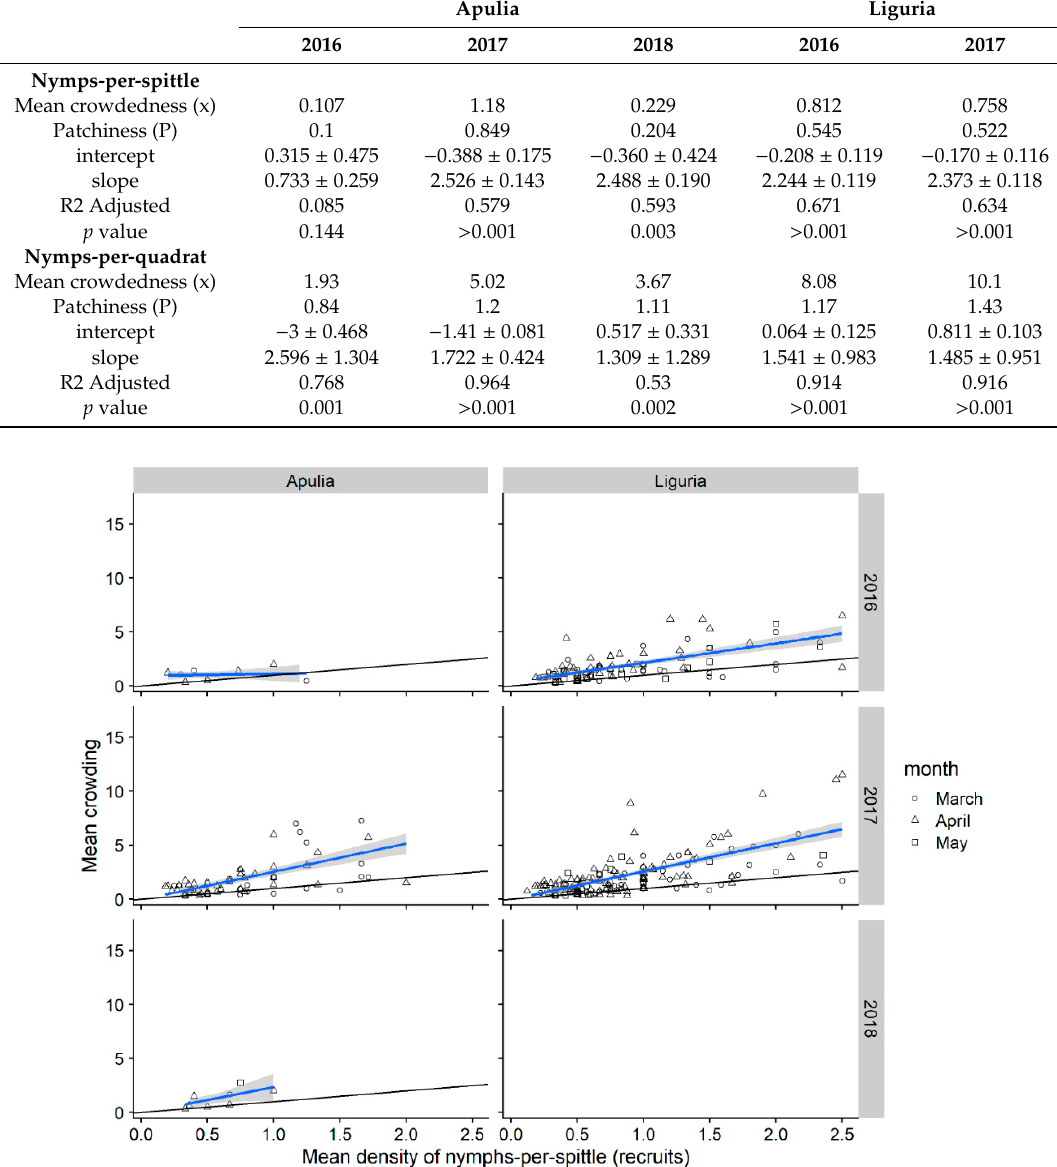
Figure 7. Relation of mean crowding to mean density of Philaenus spumarius nymphs-per-spittle in Apulia and Liguria olive groves. Blue line represents fitted values of Iwao’s regression. Black line represents x = y, expectation from Poisson series. Strong outlier data ( > 3rd quartile + 3 × IQR) were discarded. Table 1. Iwao’s mean crowdedness regression parameters of nymphs of Philaenus spumarius .